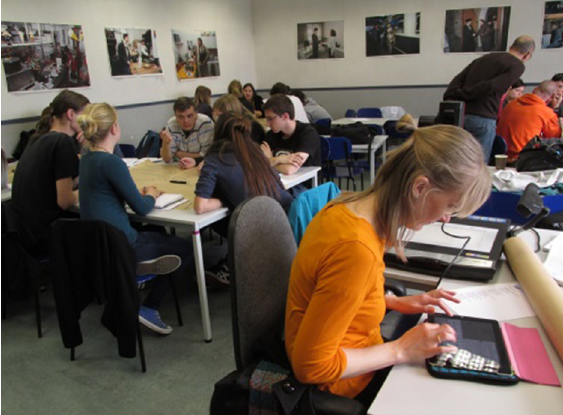
Fig. 5. Students working in multinational teams, Coll. Pollonicum (Photo I. Markuszewska,